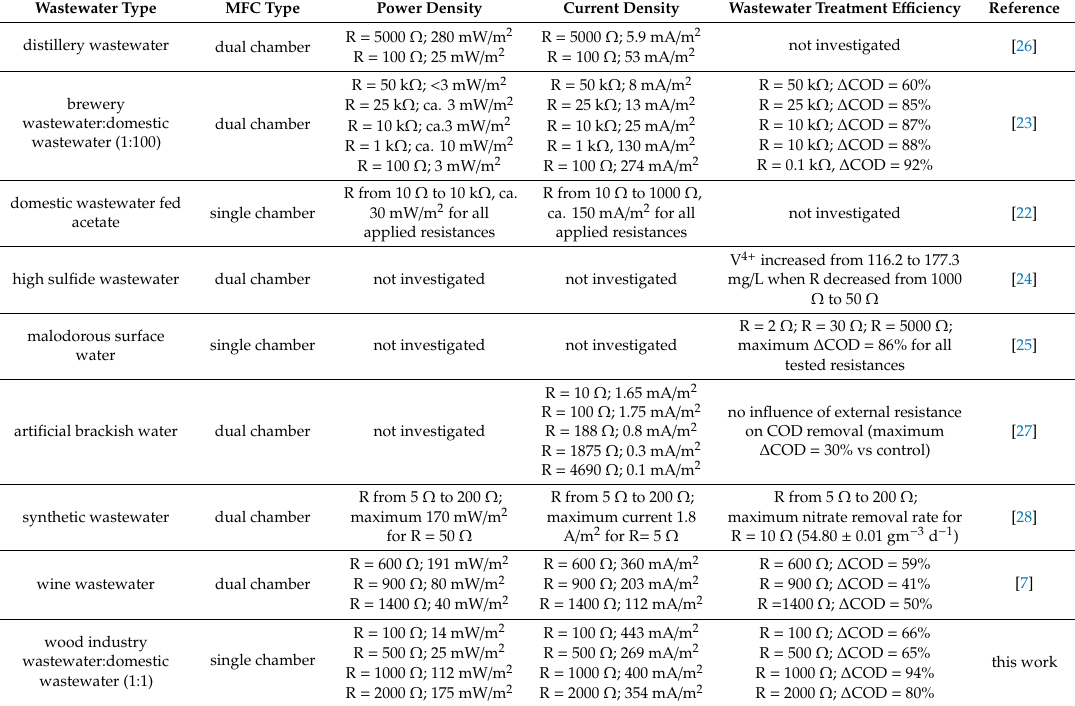
Table 1. Influence of external resistance on wastewater treatment e ffi ciency and power production in MFCs fed various types of